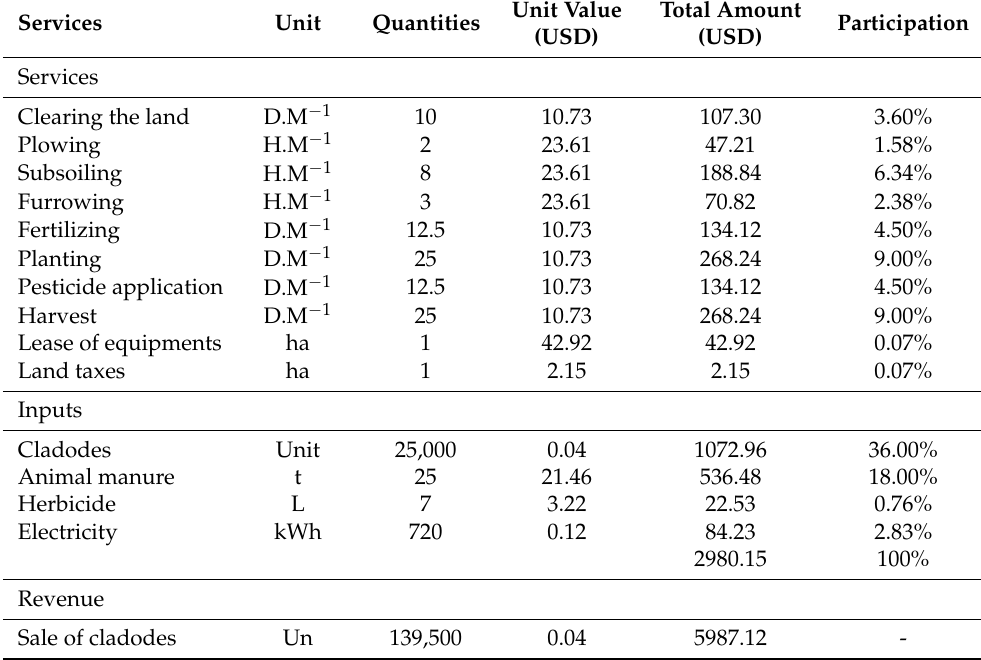
Table 8. Prices of the forage cactus cropping system.